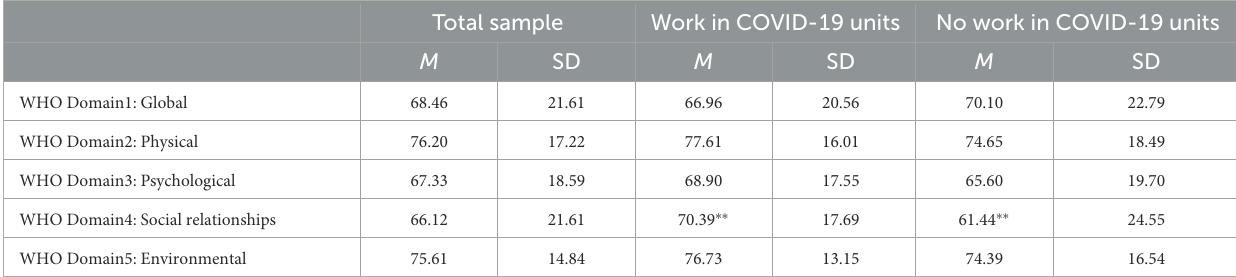
TABLE 2 Participants’ subjective quality of life after 2 years of pandemic according to